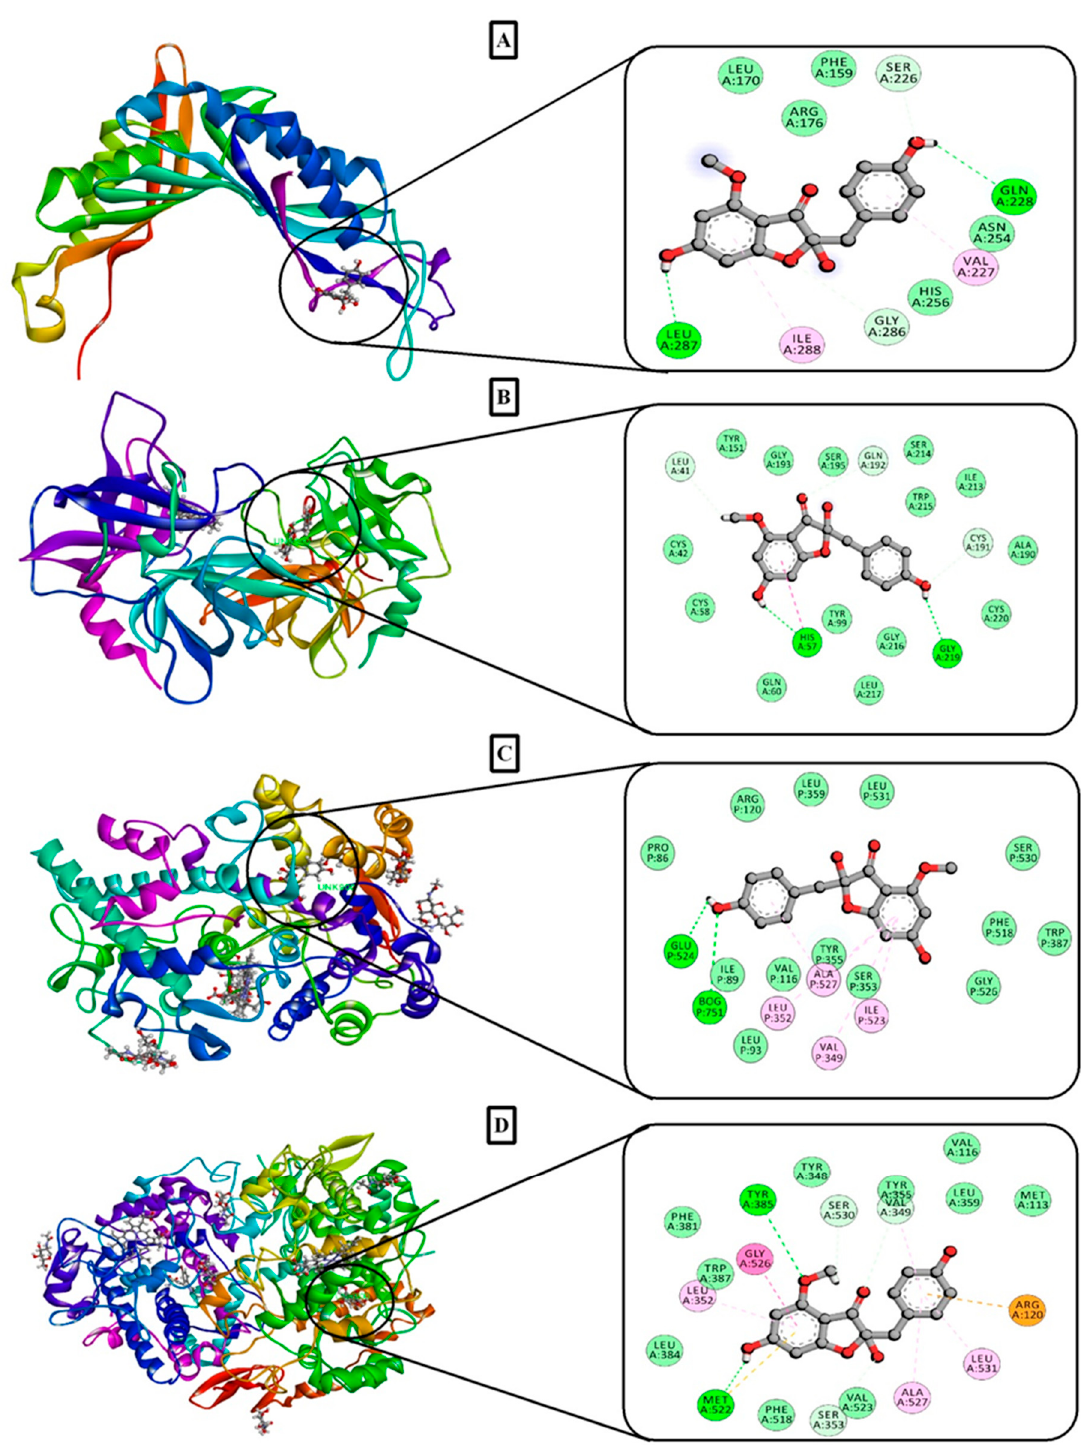
Figure 5. 3D and 2D best docking interactions of carpusin with: ( A ) 1R4U; ( B ) 1A5H; ( C ) 2OYE; and and ( D ) ( D ) 6COX.